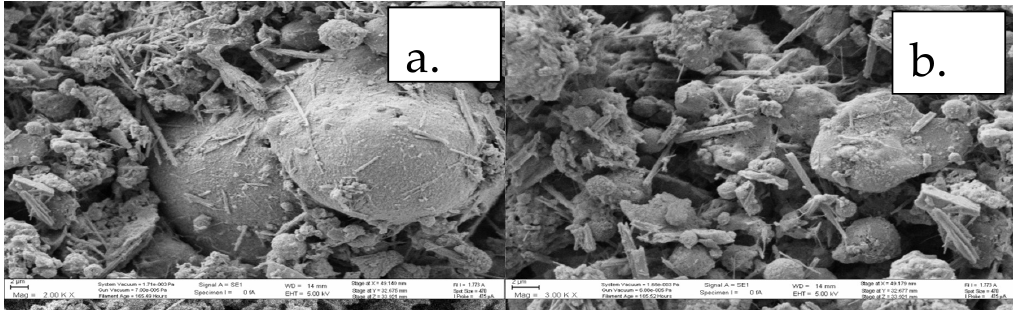
Figure 2. Scanning electron microscopy (SEM) micrographs of selected South African coal-fired power-utility coal fly ash (CFA) at ( a ) ×20,000 and ( b ) ×30,000 magnifications.